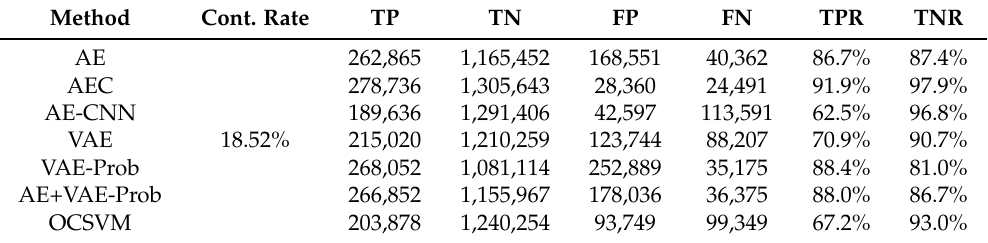
Table 5. Resulting confusion matrix for the detection of anomalies in the independent test dataset.